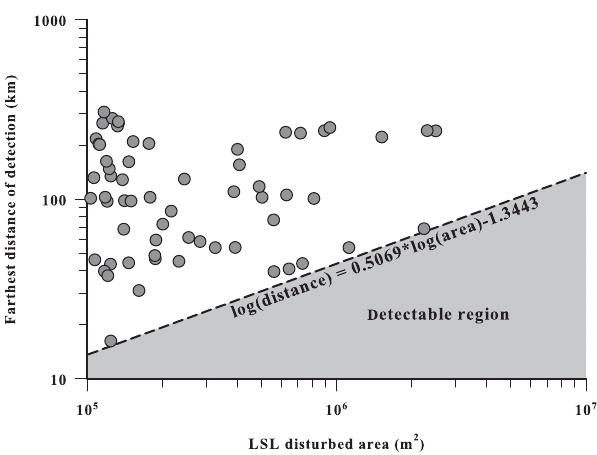
Figure 9. Maximum distance of landslide signal detection as a func- tion of landslide disturbed area. For a given large landslide, the seis- mic signal should be visible at all stations plotted beneath the